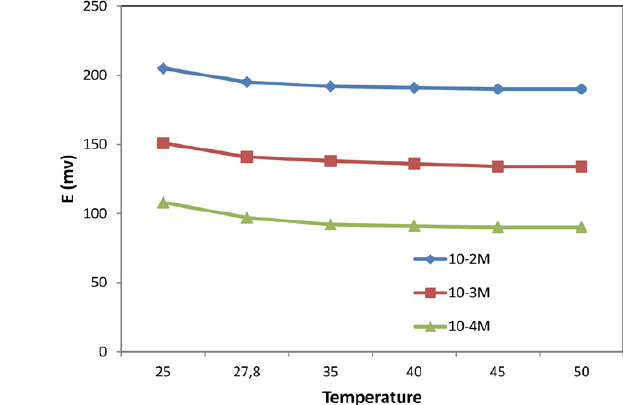
Fig. 8. Effect of temperature on the response of Lab sensor